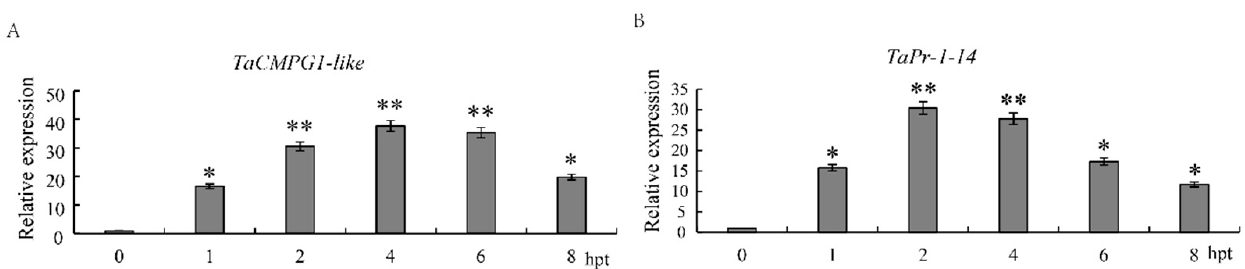
Figure 4. Expression characteristics of marker genes TacMPG1-like ( A ) and TaPr-1-14 ( B ) induced by chitin in wheat protoplasts. The relative expression of t TacMPG1-like and TaPr-1-14 was calculated by using the comparative threshold (2 − ∆∆ CT ) method, and values are expressed relative to an endogenous wheat reference gene TaActin . Bars represent standard deviations (SD), which were calculated from 3 independent biological replicates ( n = 3). Asterisks indicate significant differences calculated using Student’s t -test. (* p < 0.05, ** p < 0.01). Wheat protoplasts were isolated from wheat cultivar CN19. 0 hpt, un-treated wheat protoplasts. 1–8 hpt represent 1, 2, 4, 6, and 8 h